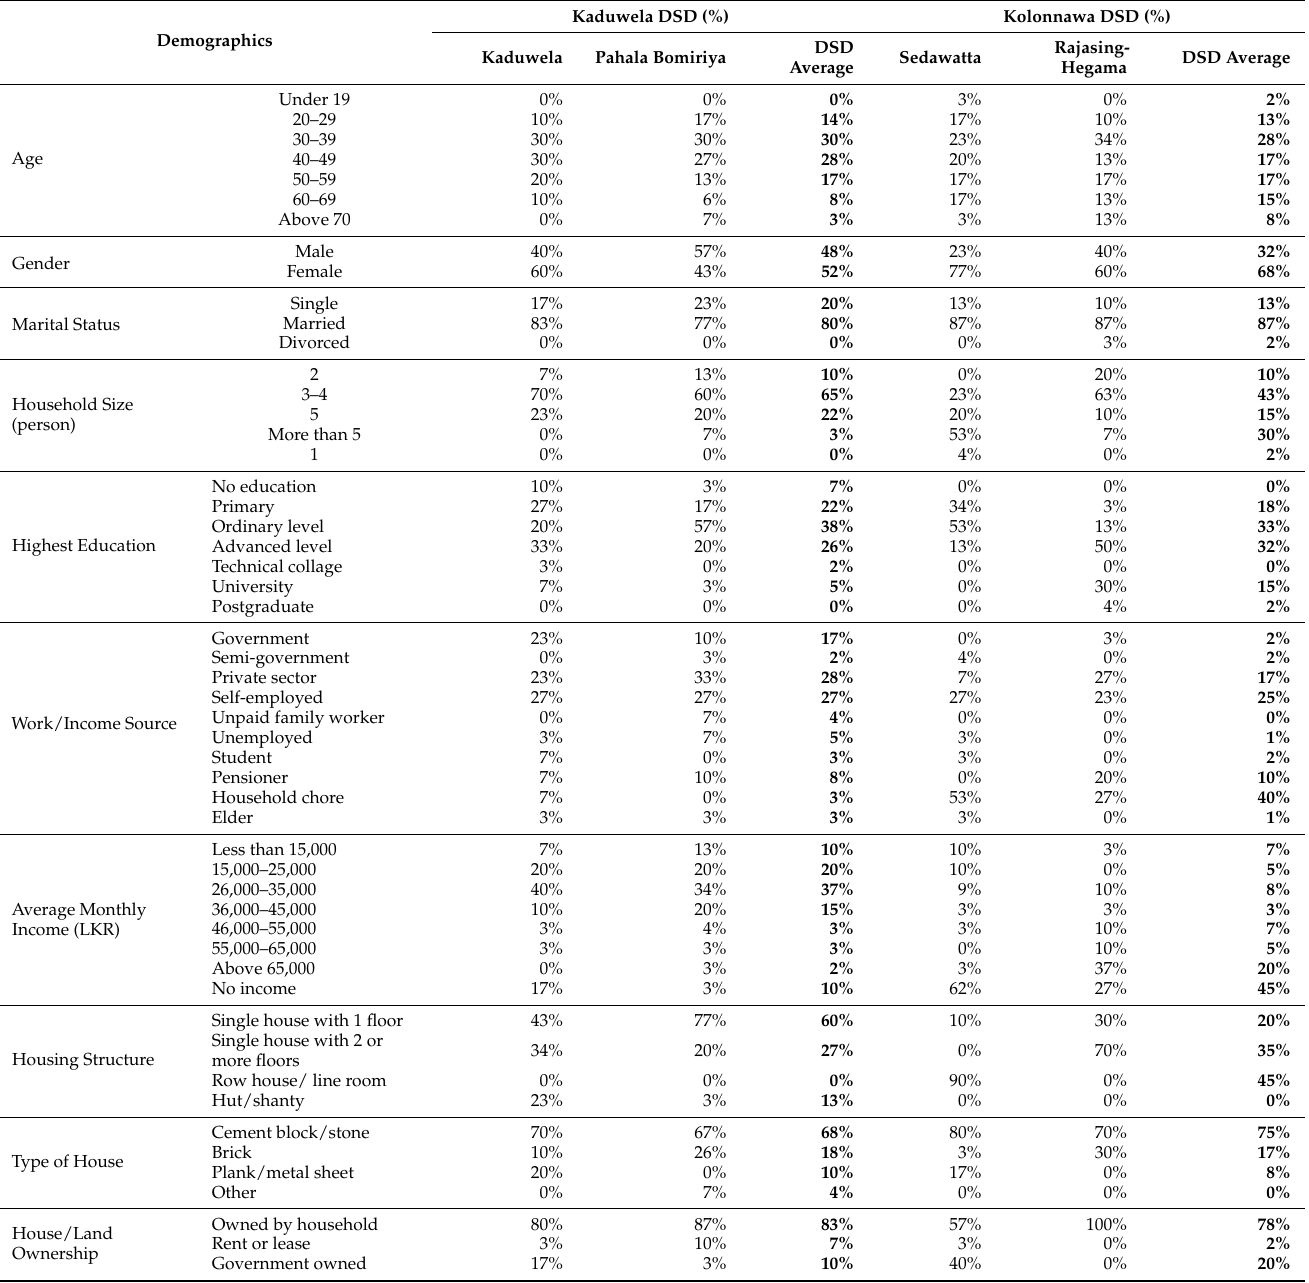
Table 1. Socio-demographic characteristics of the